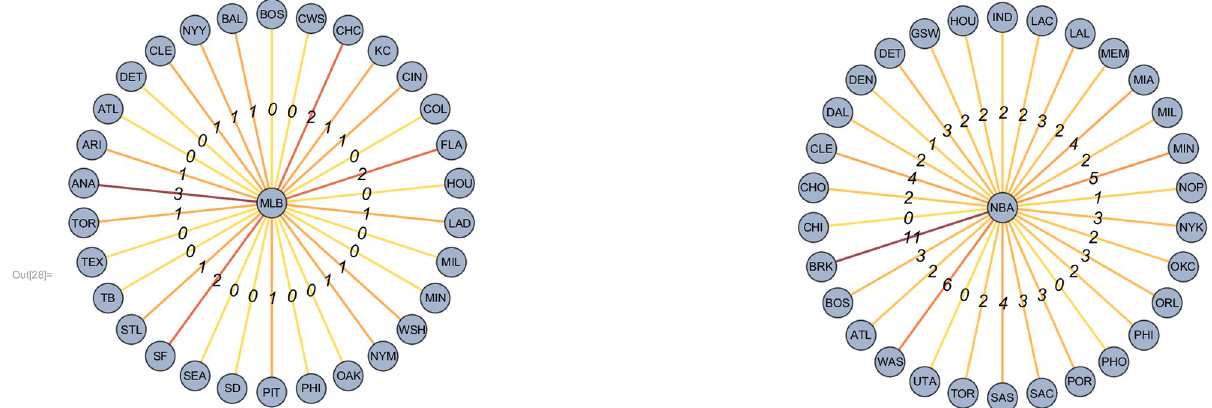
Fig 3. Left: The affinity network of a representative MLB player from the 2017 season. Right: The affinity network of a representative NBA player from the 2018 season. In both, edge weights indicate the player’s affinity score where darker edge colors indicate a higher score.